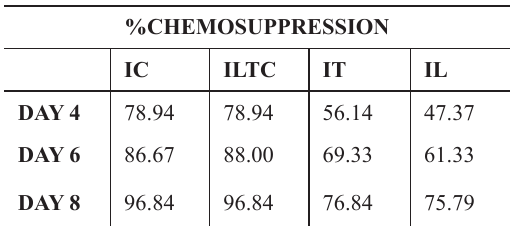
Table 2: Percentage chemosuppression of parasite in P. berghei infected mice treated with chloroquine, lumefantrine, trimethoprim, and lumefantrine-trimethoprim-copper complex.